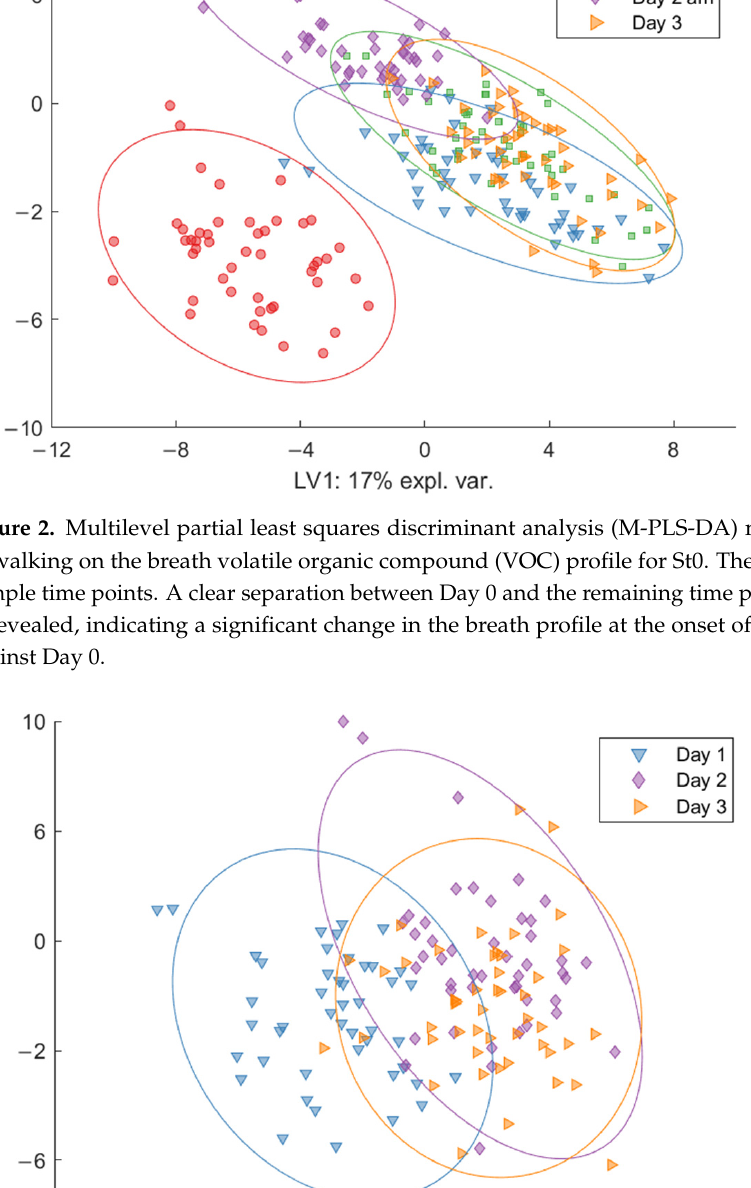
Figure 2. Multilevel partial least squares discriminant analysis (M-PLS-DA) model for the effect of walking on the breath volatile organic compound (VOC) profile for St0. The model includes all sample time points. A clear separation between Day 0 and the remaining time points (Day 1–Day pared against Day 0.